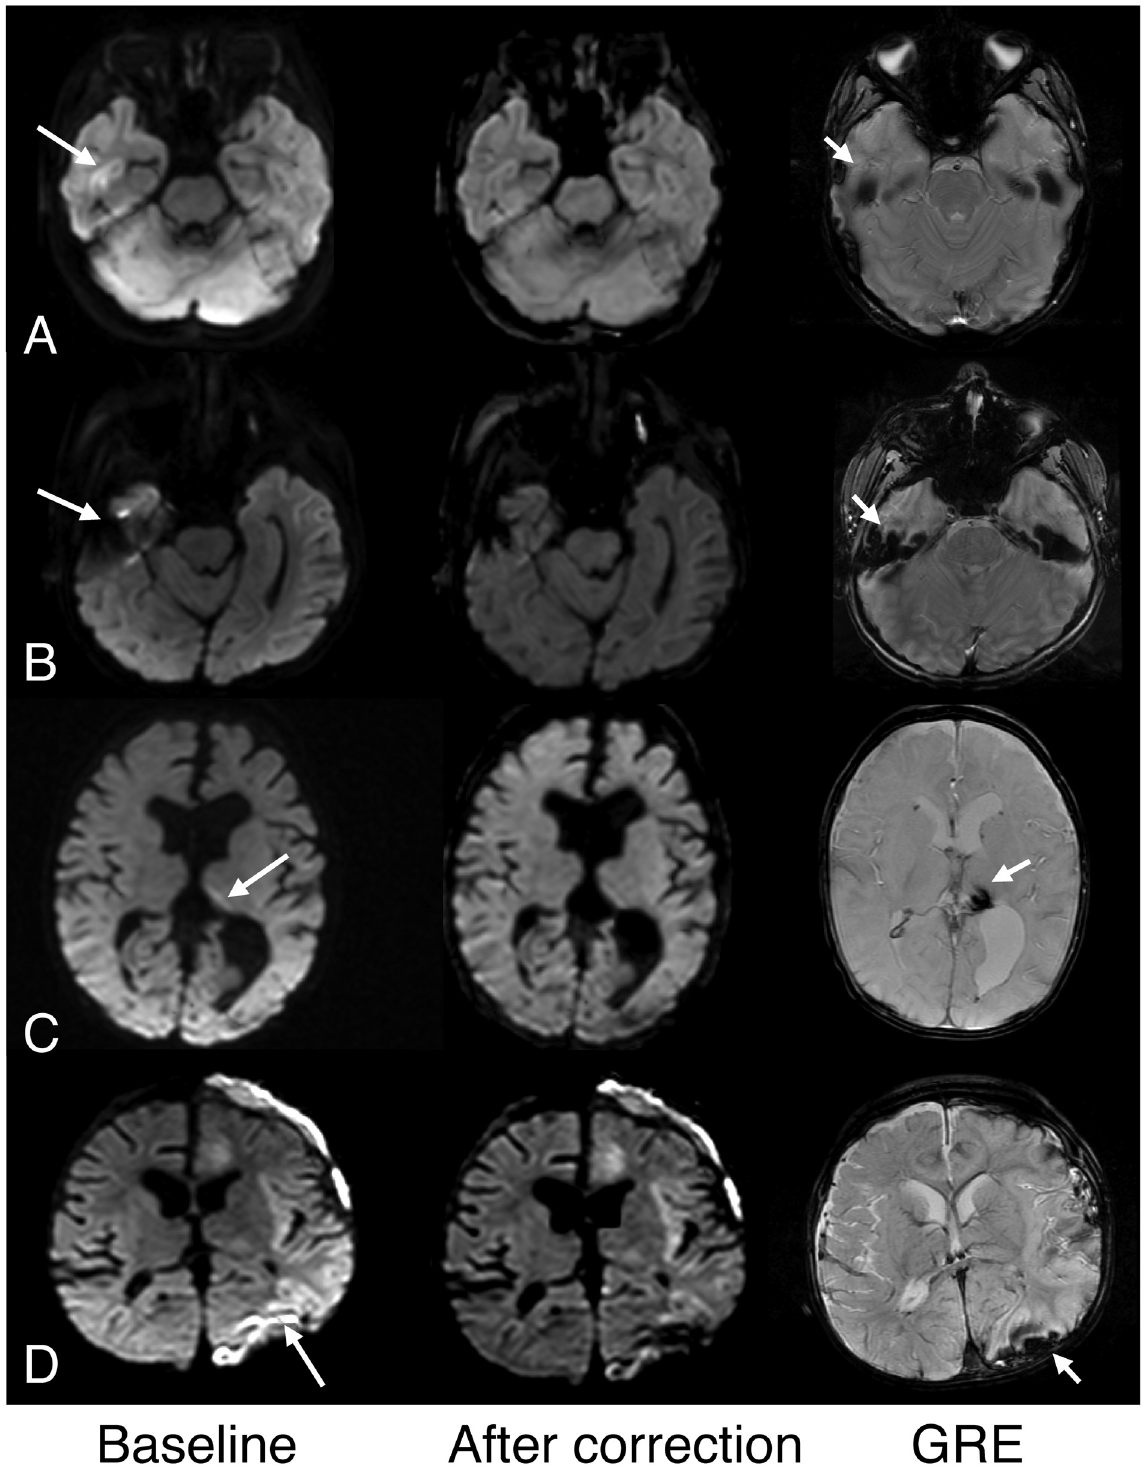
Fig 3. Examples of improved high intensity artifact associated with susceptibility after intensity correction. The columns represent baseline (Echo1 or Echo2); after correction (cEcho1 or cEcho2); and corresponding GRE images. A. High signal in the right temporal lobe cortex suggested possible pathology on Echo1 (shown here, arrow) and Echo2 (not shown) in this 6-year old girl but was considered an artifact from the temporal bone. Note improved more homogeneous brain signal on its intensity-corrected complement, cEcho1 (shown here) in both the temporal lobe and posterior brain regions. B.